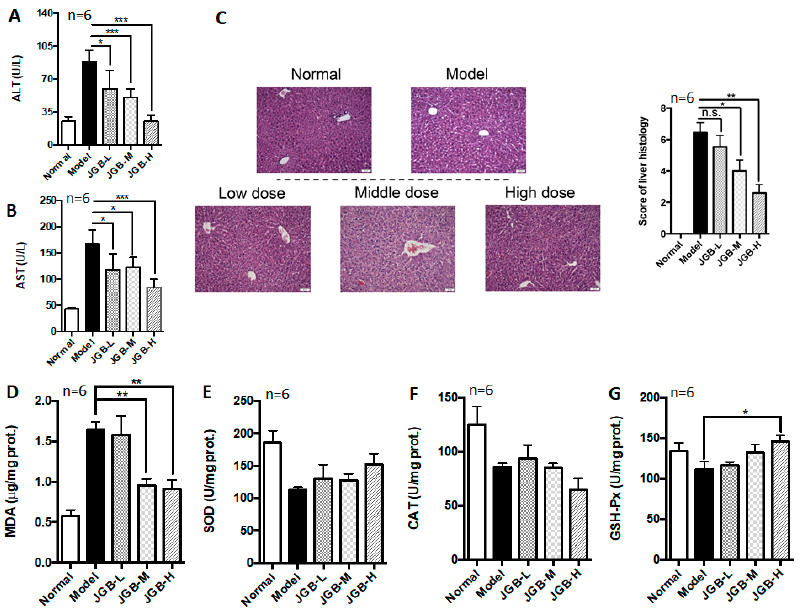
Figure 3. The effect of JGB on chronic ALD. ( A ) ALT levels of mice from different groups; ( B ) AST levels of mice from different groups; ( C ) H & E staining images and scoring of liver histology; ( D ) MDA levels in liver of mice from different groups; ( E ) SOD levels in liver of mice from different groups; ( F ) CAT levels in liver of mice from different groups; ( G ) GSH-Px levels in liver of mice from different groups. (JGB-L: JGB-low dose group, JGB-M: JGB-middle group, JGB-H: JGB-high group). Three biological replicates were performed for each study. * p < 0.05, ** p < 0.01, *** p < 0.001 when compared with model group.